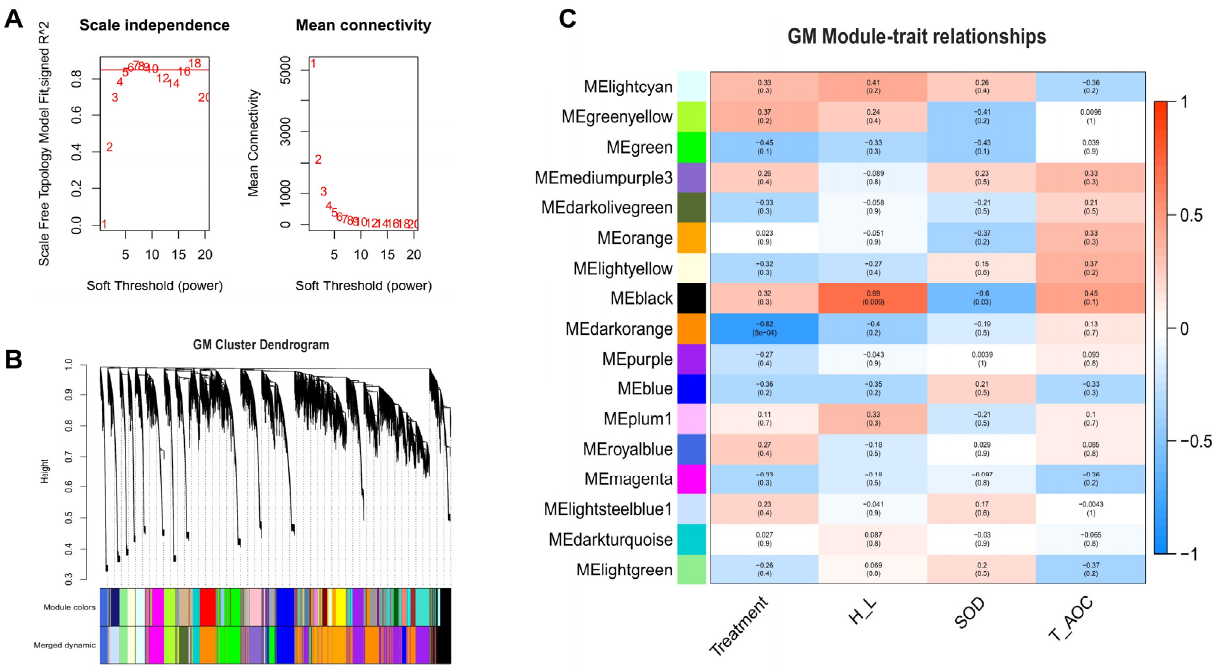
Figure 5. Weighted Gene-Co-Expression Network Analysis (WGCNA) results of Guang Ming chick- ens (liver transcriptomic) show the modules significantly correlated with treatment (heat stress) and blood indicators (H/L, SOD, and T-AOC). ( A ) Scale-free topology model and Mean connectivity. ( B ) Cluster dendrogram of Guang Ming chickens reveals the module’s colors and the merged dynamic. ( C ) Heat map of module-trait relationships, each cell has two values. The upper is the absolute value of the correlation coefficient, and down is the p -value. Red and blue colors represent positive and negative correlations, respectively.